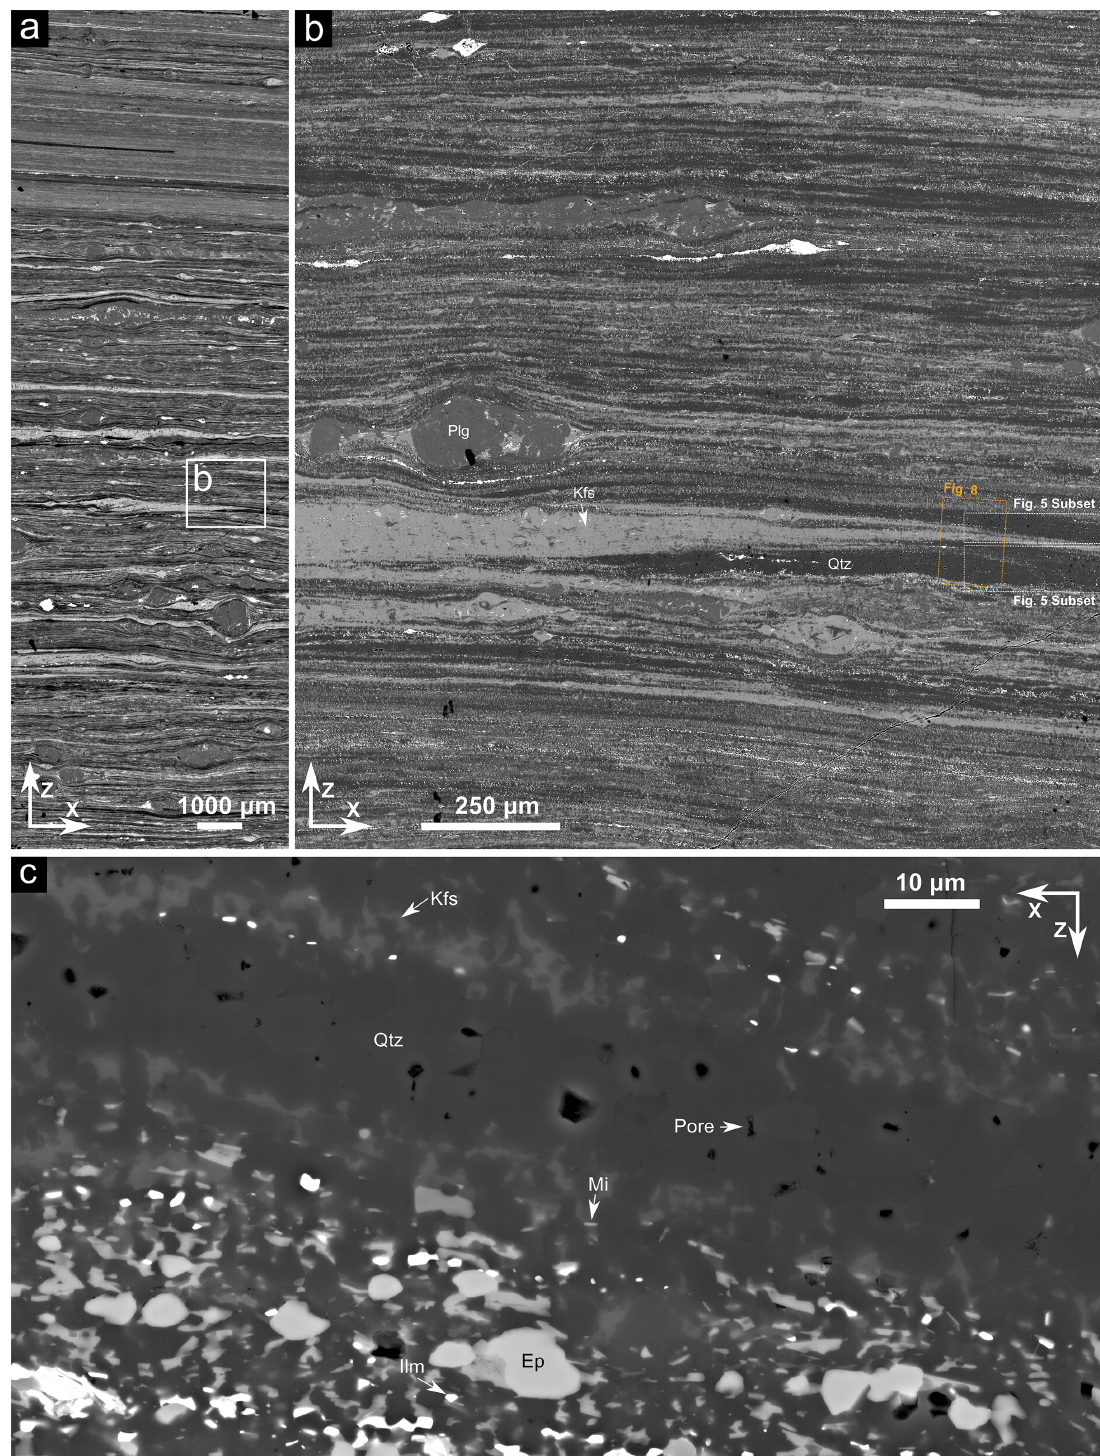
Figure 1. BSE images from the quartzo-feldspathic ultramylonite. Panel (a) shows the overall strain gradient in the sample, with the high- est strain domain found at the top of the image. Panel (b) is a high-resolution BSE SEM mosaic of a representative area of the sample (41448 × 40282 pixels, scale of 1px:35.5nm). All results presented for pore shape and orientation analysis are from the area of Fig. 1b. The greyscale values identify minerals as follows: black: porosity, dark grey: Qtz, grey: Plg, light grey: Kfs, bright: accessory phases. Panel (c) presents the edge of a disaggregating quartz domain and highlights the minerals present in the poorly mixed polyphase domains.